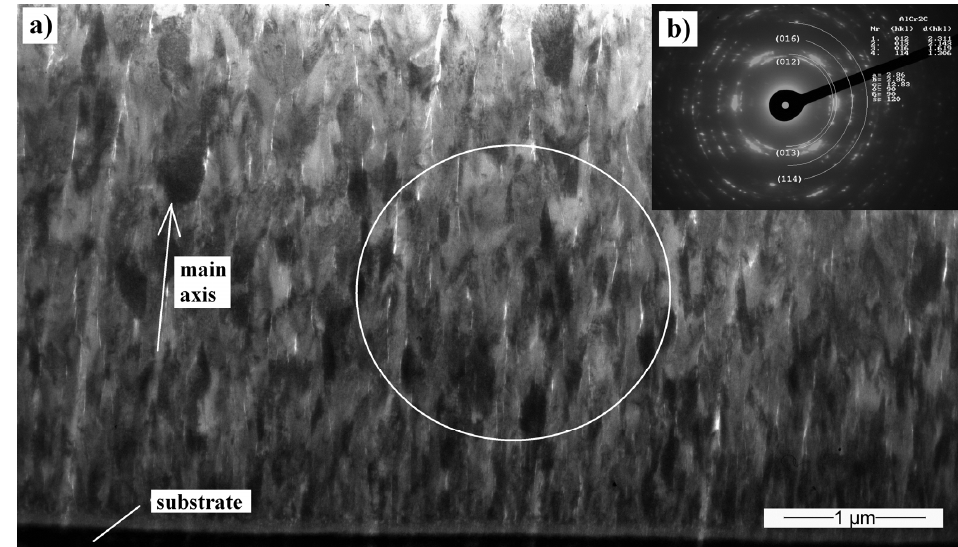
Figure 7. ( a ) Transmission electron microscopy (TEM) cross-sectional bright-field (BF) image of the Cr 2 AlC coating, deposited at 90 V. ( b ) Selective area electron diffraction (SAED) obtained in the place marked by the circle.